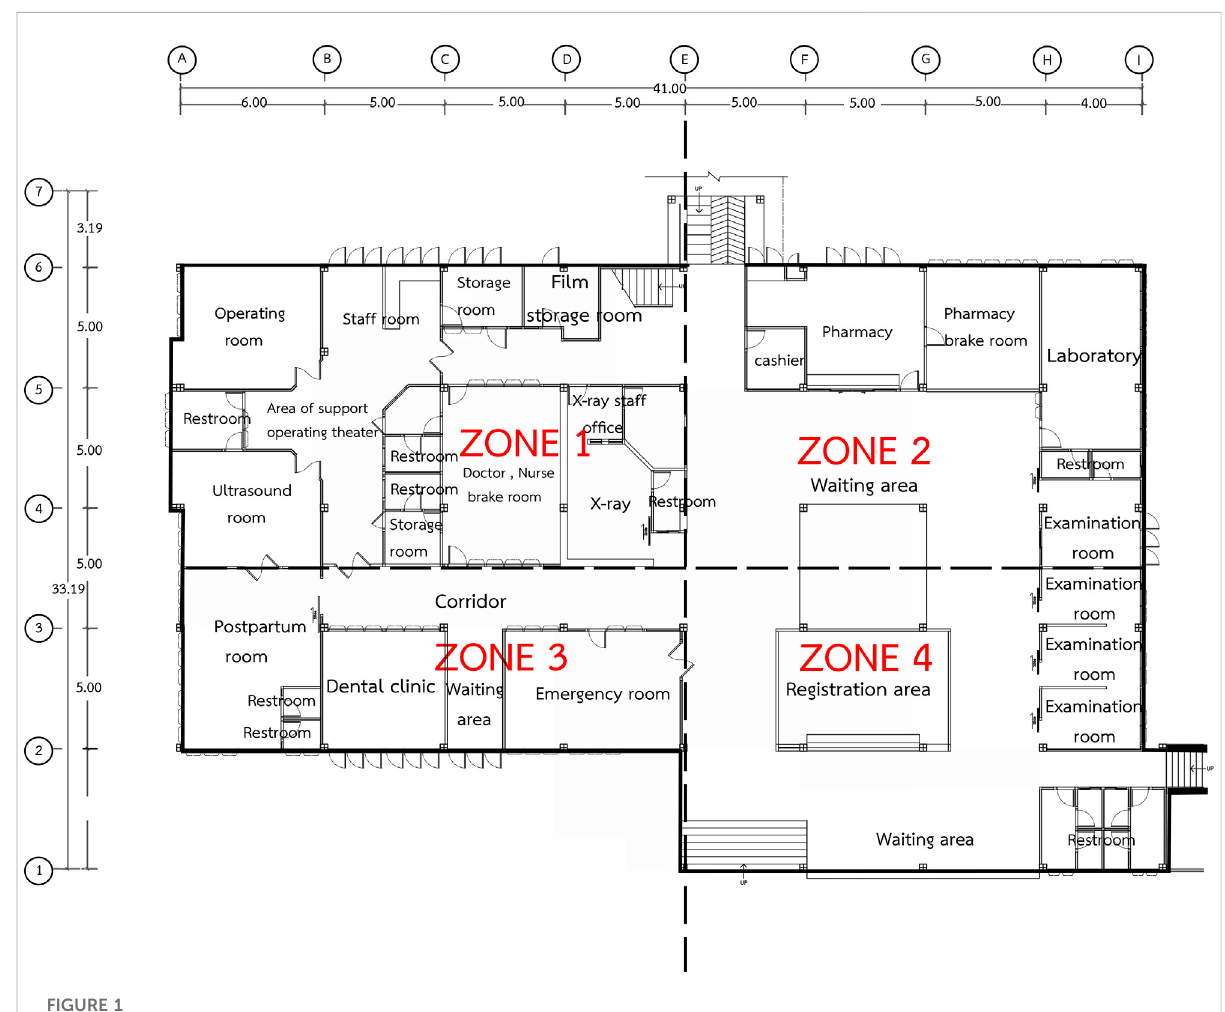
FIGURE 1 Overall layout of no. 3130